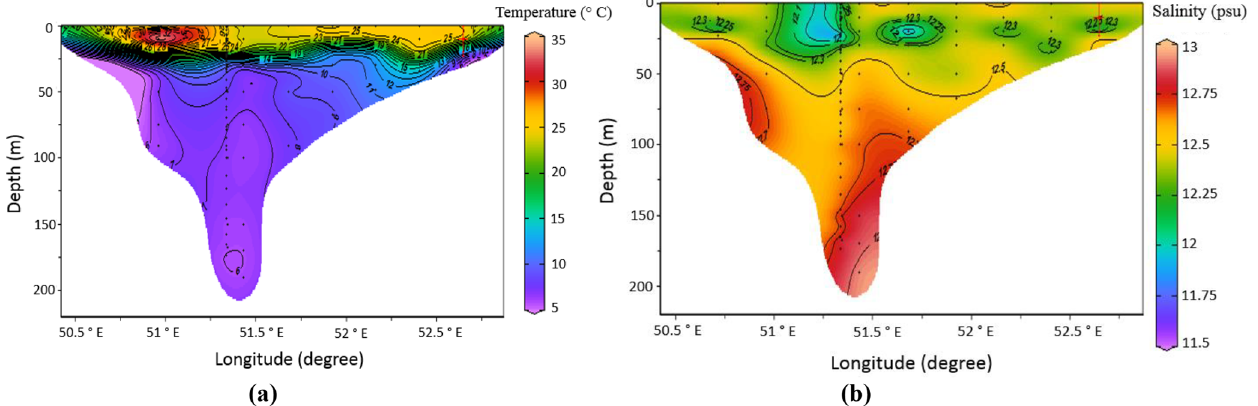
Figure 3. Cross sections of temperature and salinity across the strait at transect I (across the Absheron Strait over the sill) in September from observational data; dots show the locations of measurements.